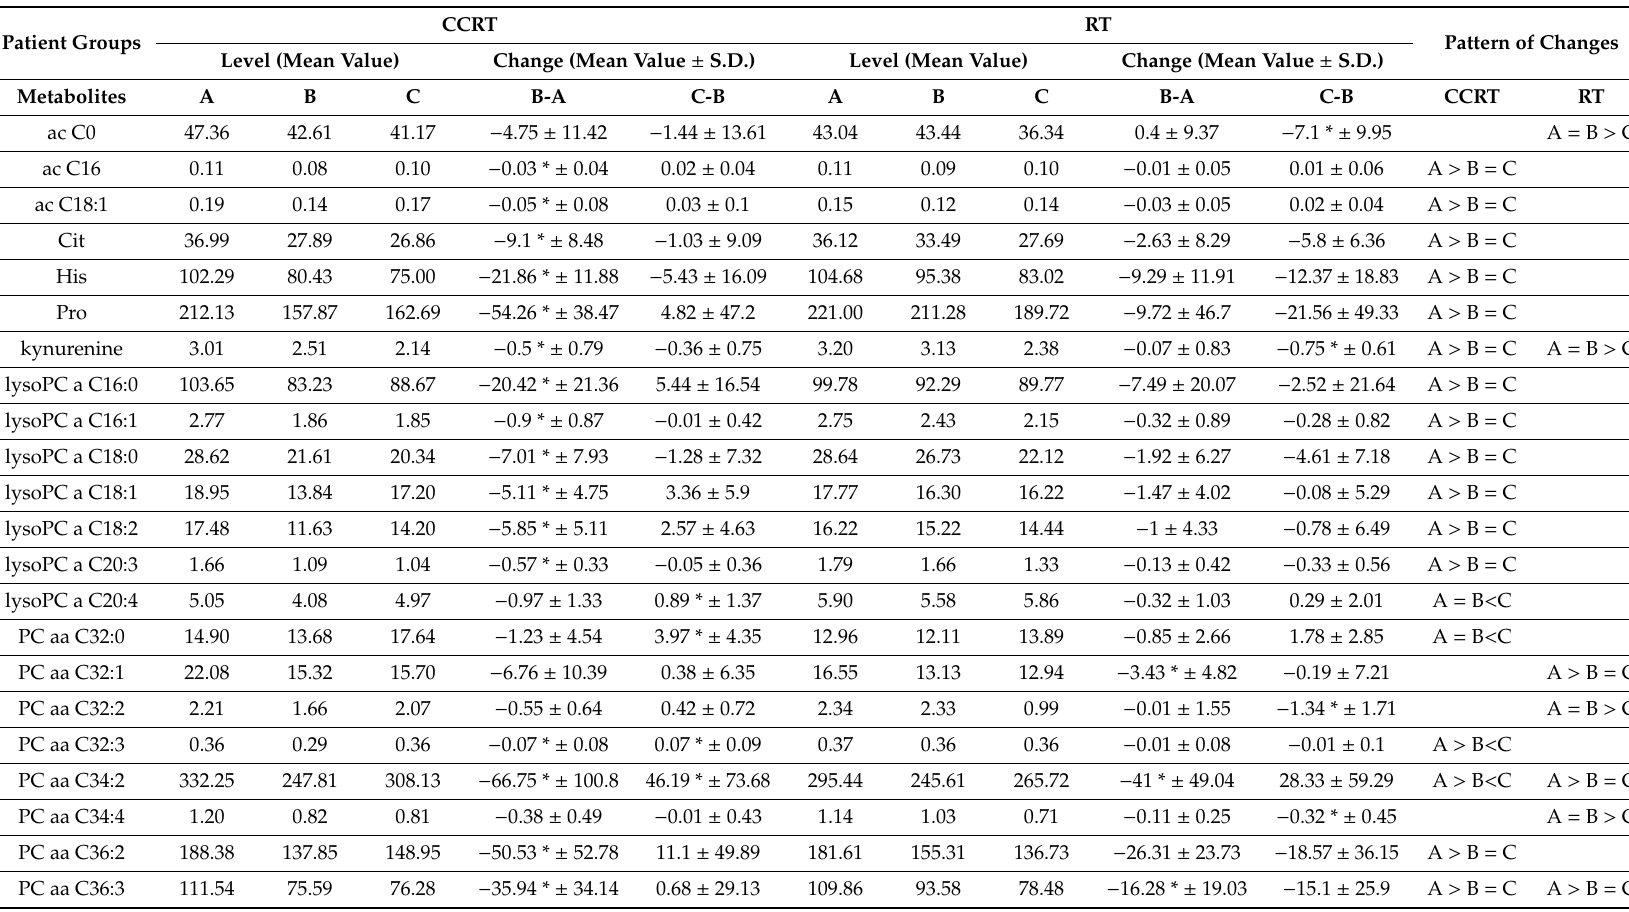
Table 1. Treatment-induced changes in serum metabolites. The following columns show their levels in the subsequent samples ( µ M; mean values in samples A, B, and C) and changes between them (change B-A and C-B, mean values ± standard deviation; asterisks mark statistically significant changes - false discovery rate (FDR) > 0.05). Patterns of changes between A vs. B and B vs. C are also presented (empty cells correspond to no significant change in both stages of treatment; i.e., pattern A = B =